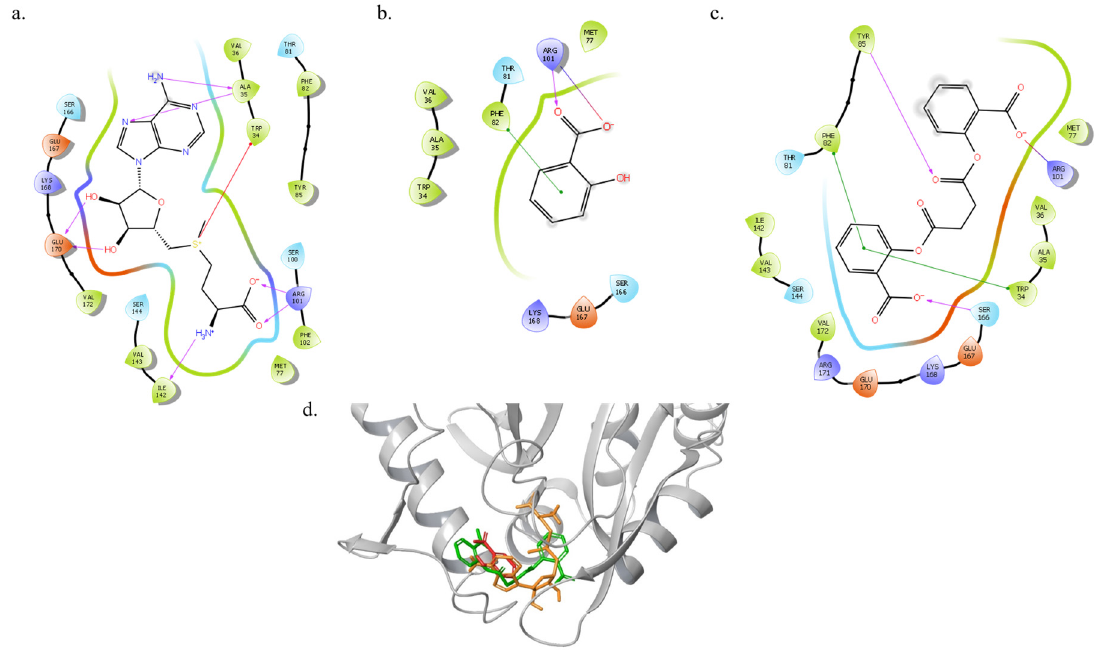
Figure 2. Homology models of ExpI and 2D/3D docking poses of S -adenosyl methionine (SAM), salicylic acid (SA) and DSA in the merged ExpI site. ( a ) SAM forms five hydrogen bonds: two with the side chain of Arg101 and Glu170 and three with the backbone of Ala35 and Ile142. SAM also forms a salt bridge with Trp34. ( b ) SA forms a hydrogen bond and a salt bridge with the side chain of Arg101 and has one π – π interaction with the side chain of Phe82. ( c ) DSA forms a salt bridge with the side chain of Arg101, has two π – π interactions with Phe82 and Trp34, and forms two hydrogen bonds with the side chains of Tyr85 and Ser16. In the 2D presentation, red spheres represent positively charged residues, blue spheres represent negatively charged residues and green spheres represent hydrophobic residues. Pink arrows represent hydrogen bonds and green lines represent π – π stacking. ( d ) Superimposition of SAM, DSA and SA. Binding modes for SAM, DSA and SA as determined by the Glide SP binding site of ExpI. Carbon atoms of SAM, DSA and SA are colored orange, green and red, respectively.